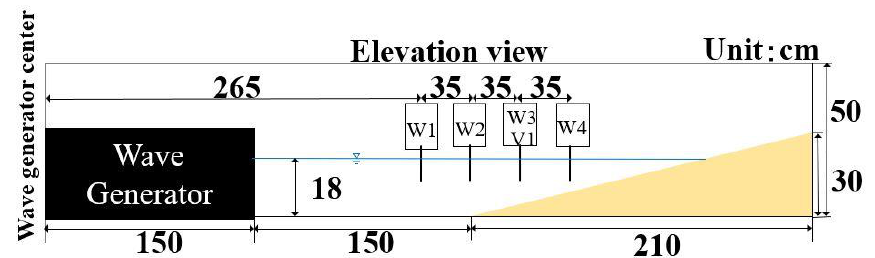
Figure 2. Initial topographic cross-section, W: wave gauge, V: velocity gauge.